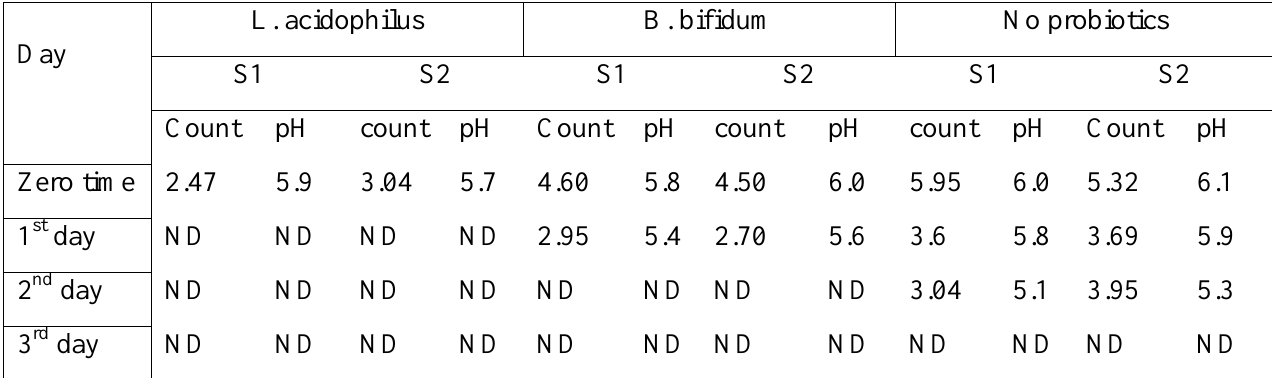
Zero time = time of fermentation, ND = not detected, S1 = strain 1 of H. pylori and S2 = strain 2 of H. pylori